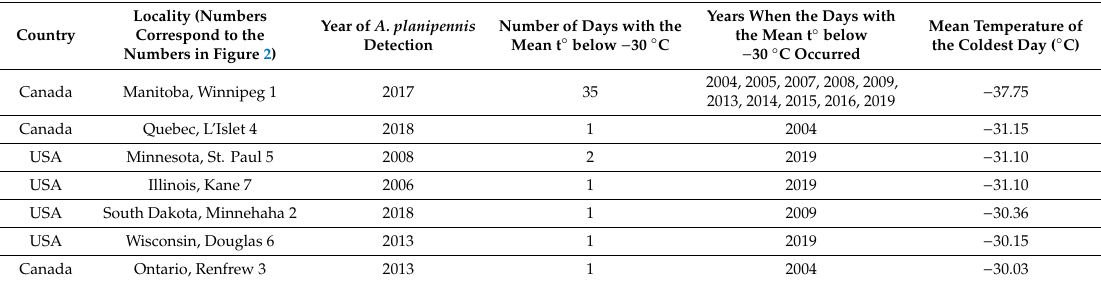
Figure 2. Mean temperature of the coldest day recorded from 2003 to 2019 in the territories currently occupied by A. planipennis in North America. Some localities where the daily temperature fell below − 30 °C are numbered. The detailed information for each of these localities is provided in Table 2. Table 2. Some A. planipennis localities in North America where the average temperature of the coldest day from 2003–2019 was below − 30 °C *.